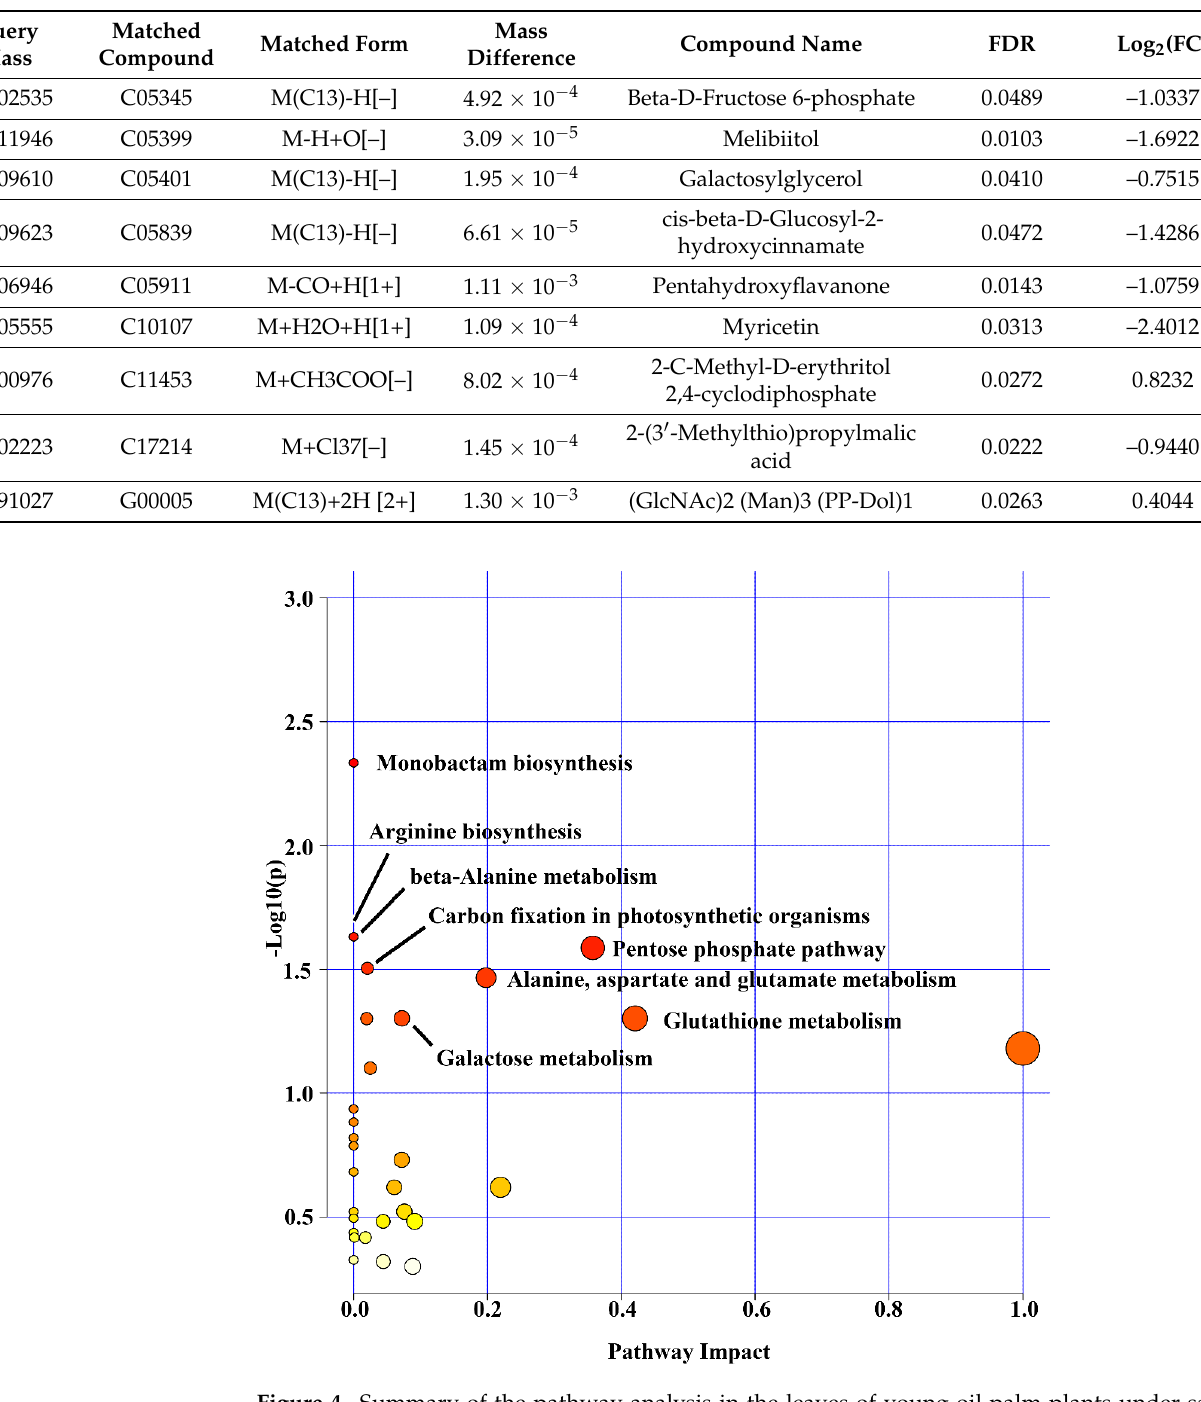
Figure 4. Summary of the pathway analysis in the leaves of young oil palm plants under